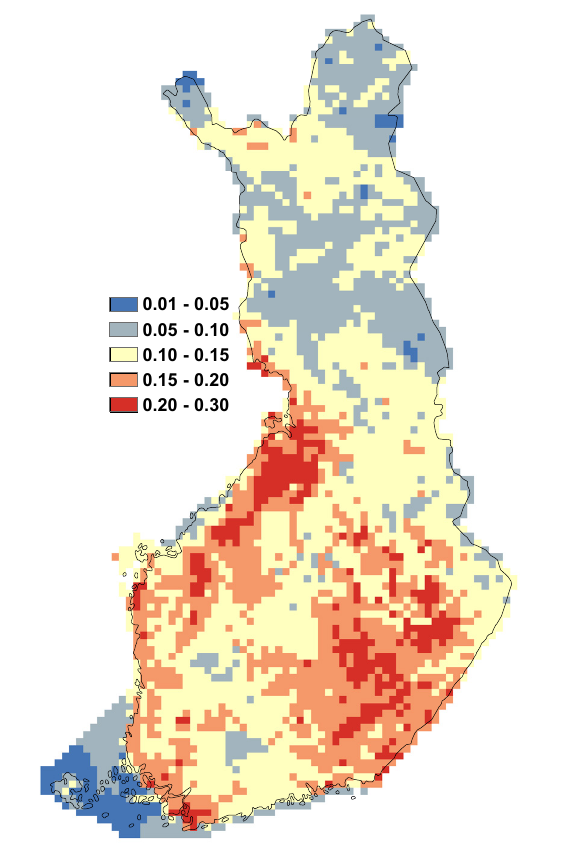
Fig. 3. Variation in probabilities of fluctuation from mild to cold spells outside the growing